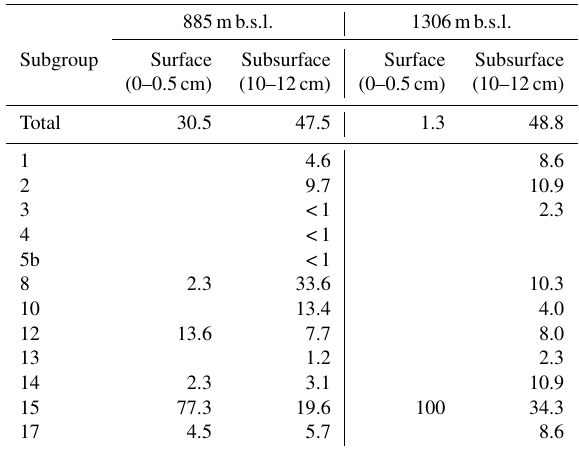
Table 4. Relative abundance (in %) of MCG- and C3-assigned 16S rRNA gene reads relative to total archaeal reads and distribution (in %) of various subgroups for a station within and a station just below the OMZ.